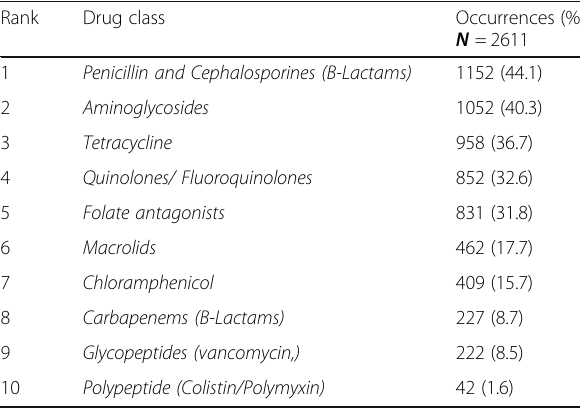
Table 1 Top ten frequent drug classes encountered in the retrieved documents (AMR in the environment) during the study period from 2000 to